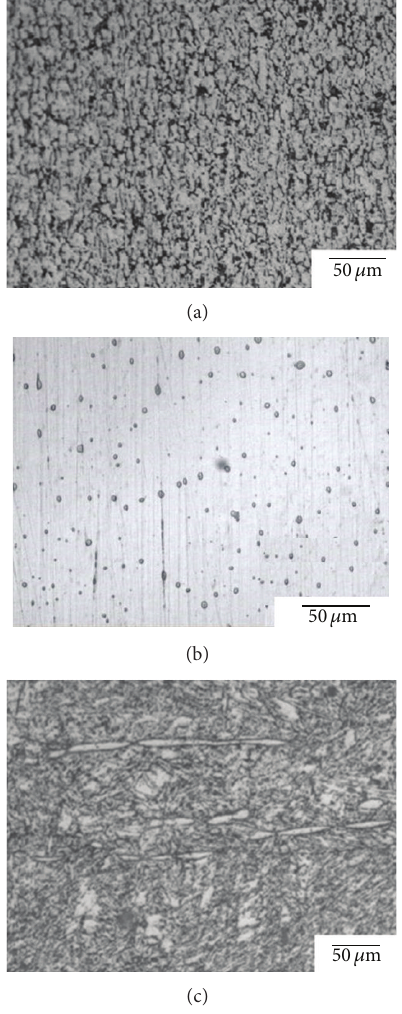
Figure 1: Optical micrograph of substrate materials. (a) Ti-31, (b) Superco-605, and (c)